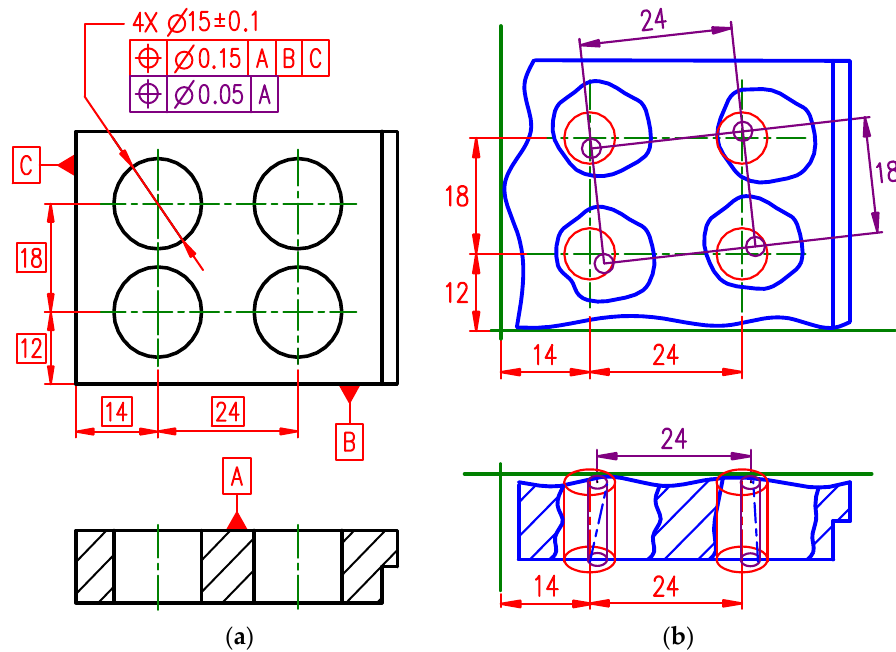
Figure 13. ( a ) Position tolerance T = 0.15 mm locates the pattern with respect to datum system A|B|C, position tolerance T = 0.05 mm refines the mutual location between holes and limits tilting of the pattern with respect to the datum A (ASME Y14.5); ( b ) tolerance zones—meaning of two level specification.